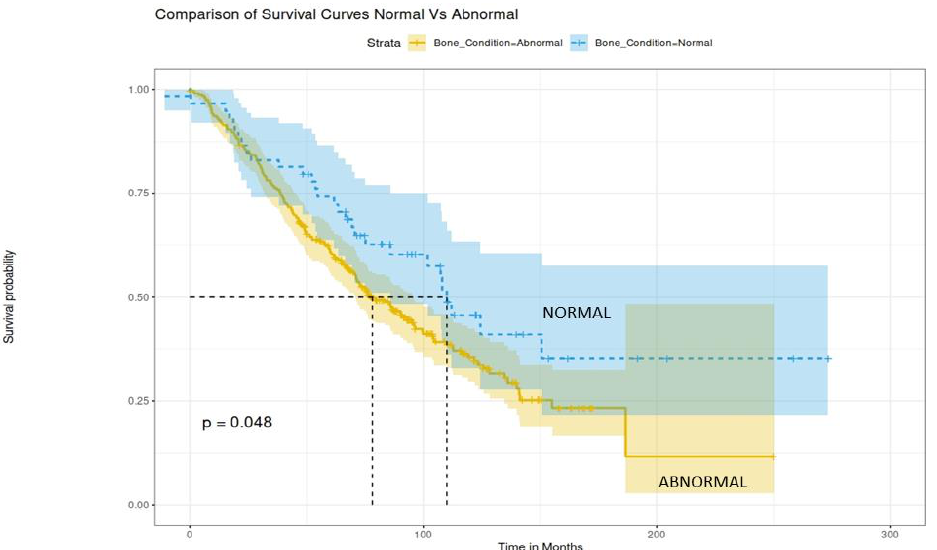
Figure 1. OS curves according to bone condition at MM diagnosis. Normal bone condition signifies absence of SREs and normal MRI pattern, whereas abnormal bone condition signifies presence of at least one SRE and/or abnormal MRI pattern.